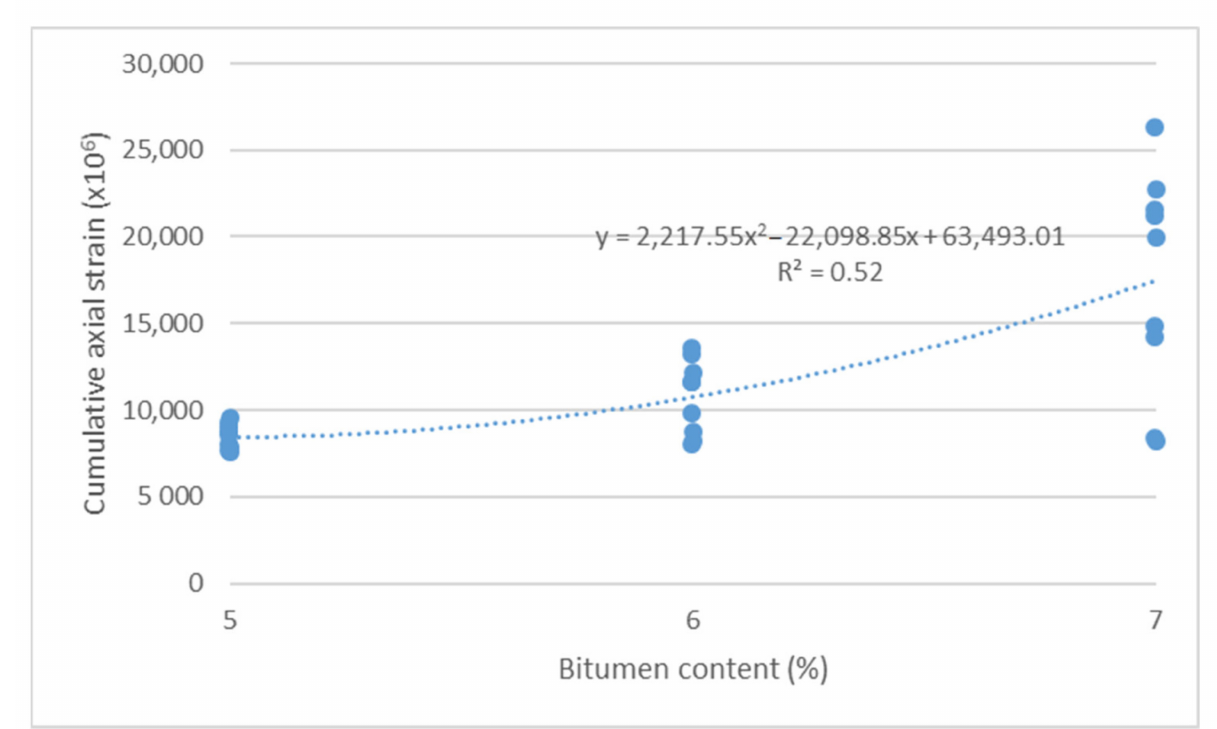
Figure 3. Cumulative axial strain vs. bitumen